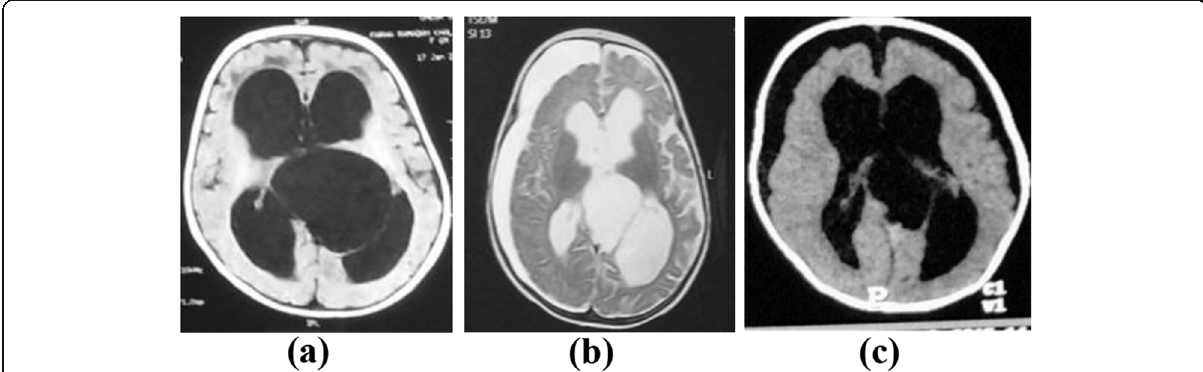
Fig. 9 a MRI T1 axial sequence showing quadrigeminal arachnoid cyst bulging inside the lateral ventricle in a 6-month-old male. b MRI T2 axial sequence after 1 month showing marked decrease in the size of the cyst and resolution of hydrocephalus with development of chronic subdural hygroma after performing endoscopic ventriculocystostomy and third ventriculostomy. c Follow-up CT after 3 months postoperatively showing reduction of the size of chronic subdural hygroma without